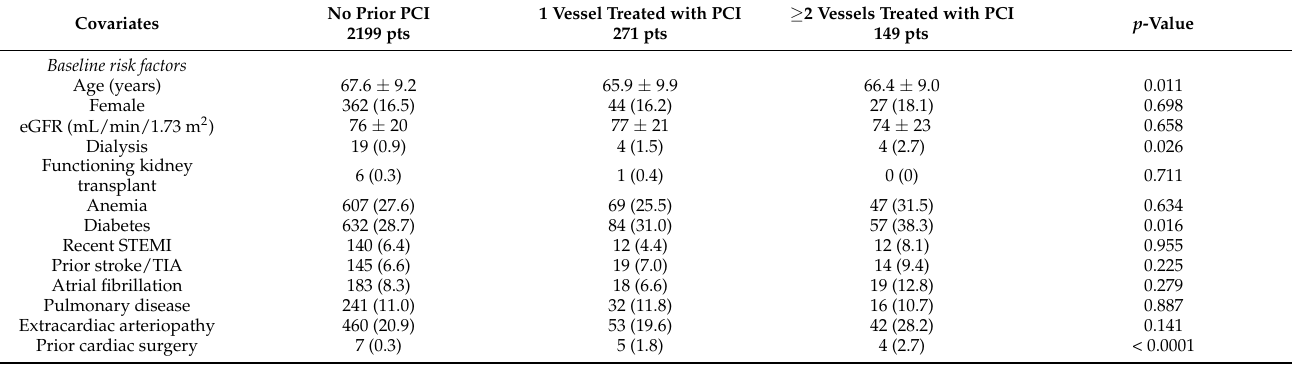
Table 3. Baseline characteristics and operative data in the unmatched and matched